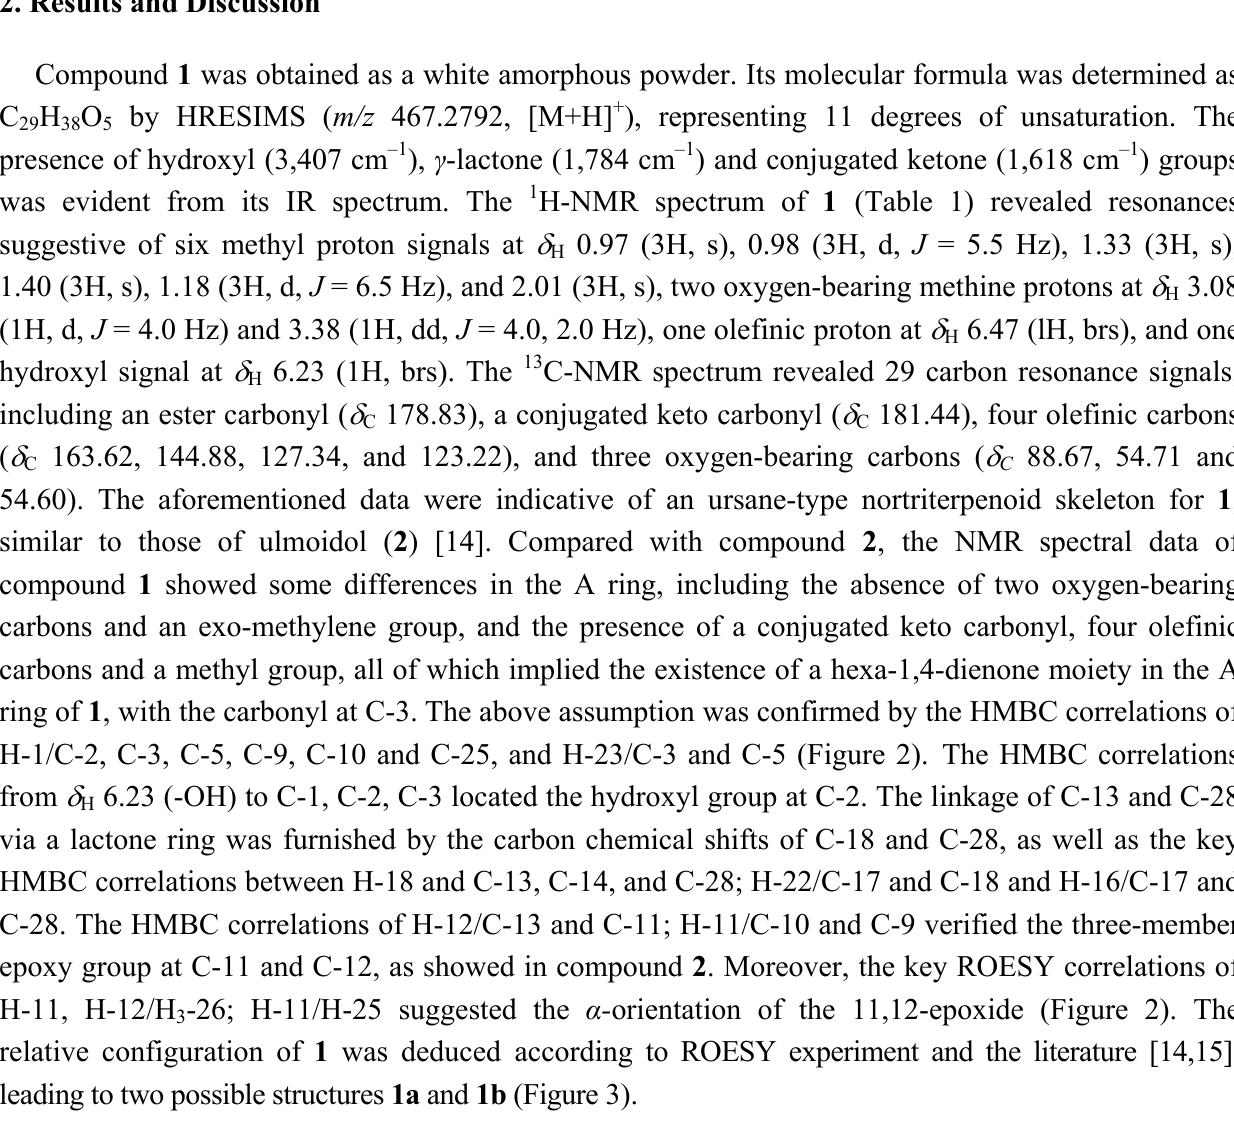
Table 1. NMR data of compound 1 in CDCl